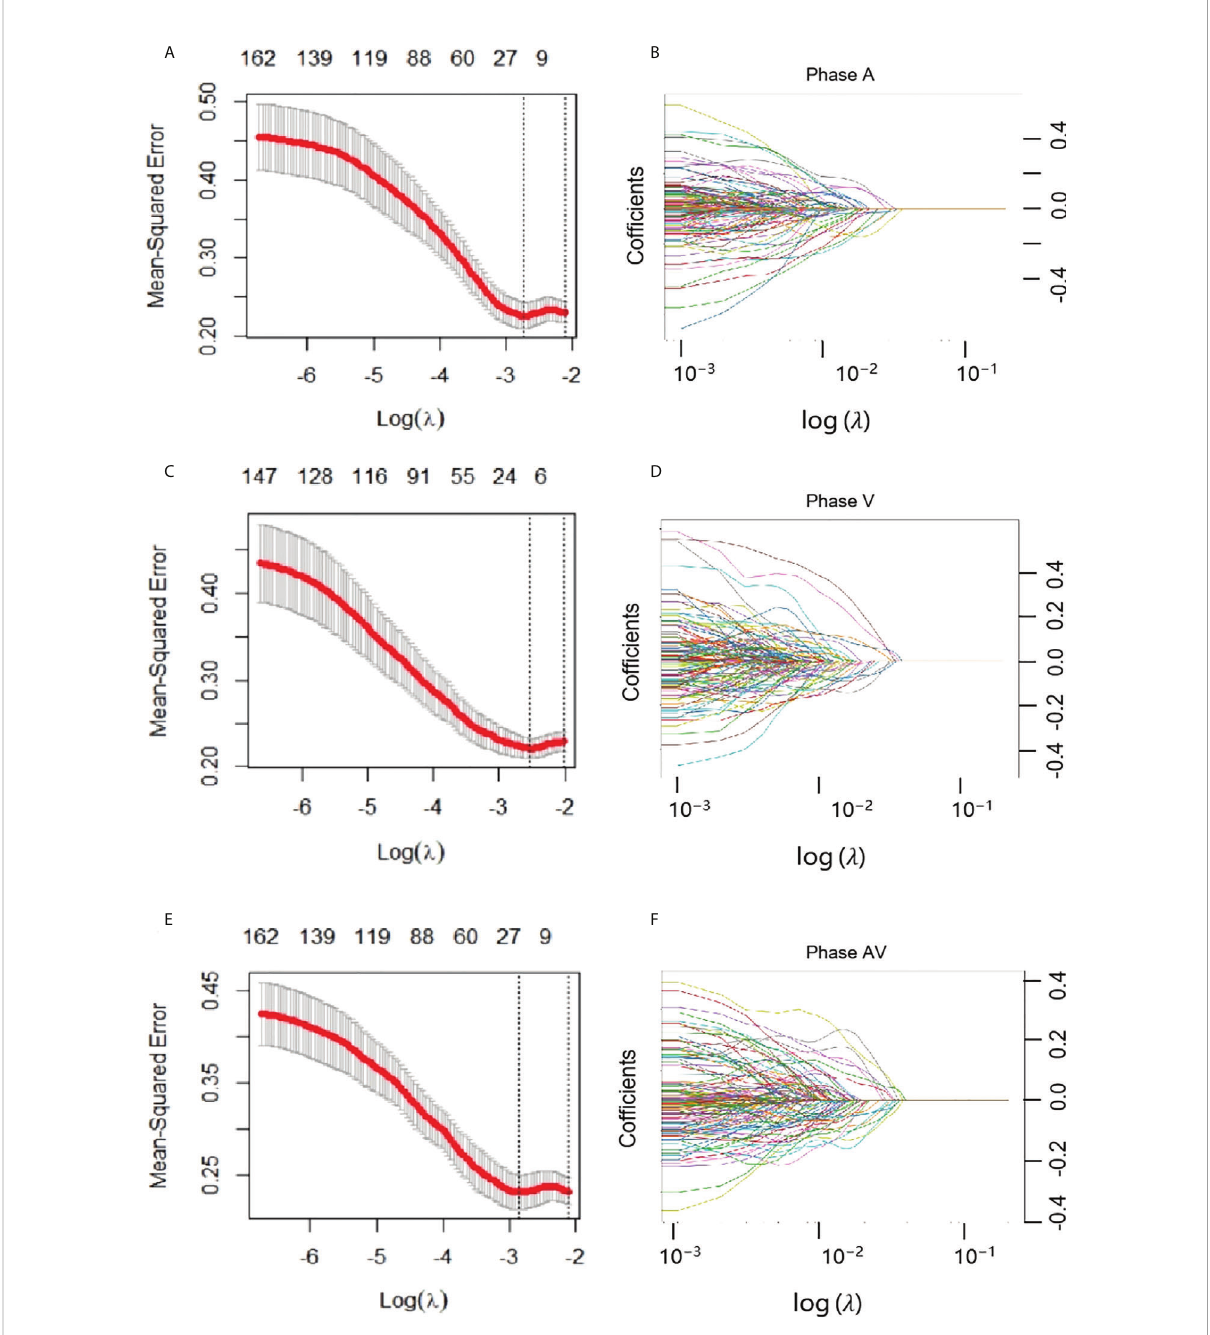
FIGURE 3 Feature selection with the least absolute shrinkage and selection operator (LASSO) model. (A, B) represented AP model, and (C, D) represented VP model, and (E, F) represented AP+VP model. (A, C, E) The LASSO model ’ s tuning parameter ( l ) selection used fi ve-fold cross-validation via minimum criterion. The vertical lines indicate the optimal value of the LASSO tuning parameter ( l ). (D, E, F) LASSO coef fi cient pro fi le plot with different log ( l ) was